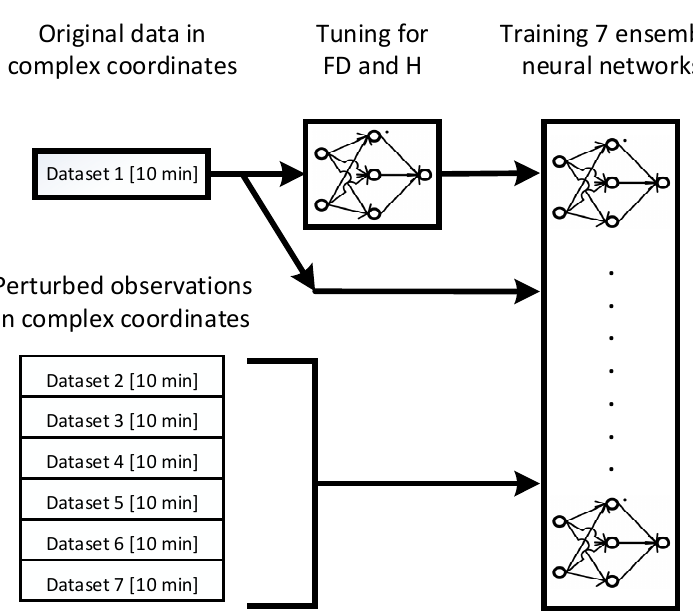
Figure 4. Training of the ensemble neural network model using seven datasets as input. The seven datasets include the original data set, and the remaining six are the output of previous stage of pre-processing Section 3.1.